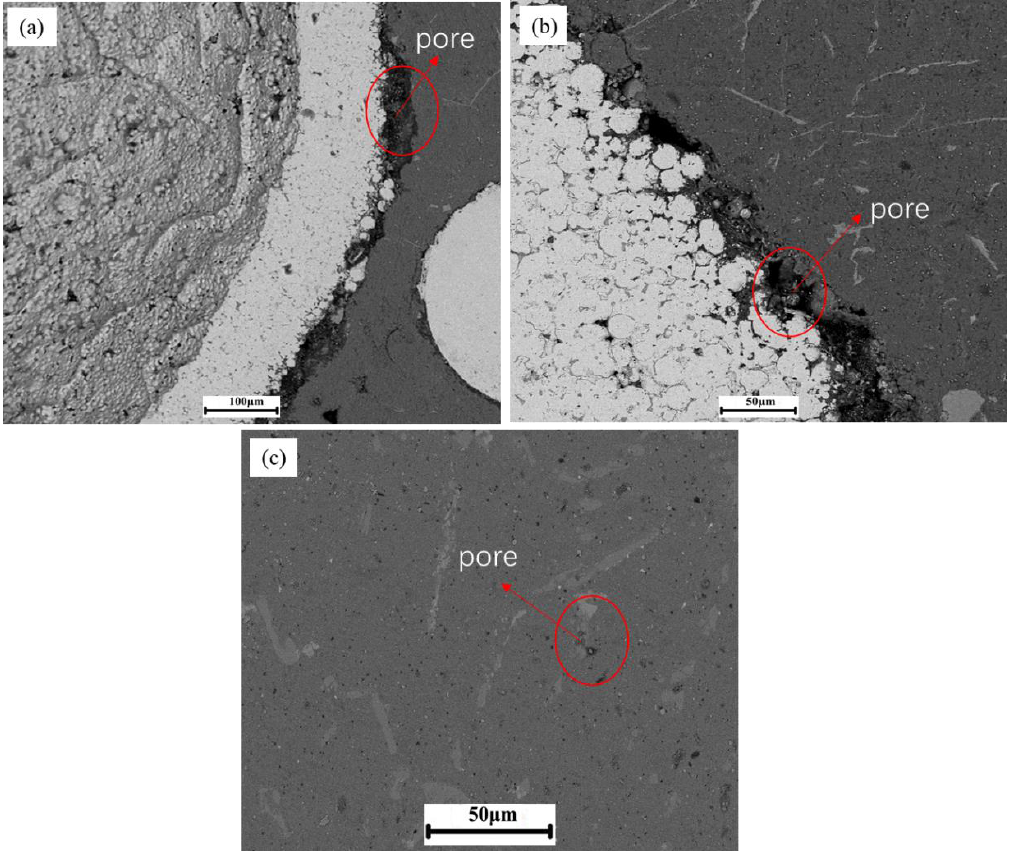
Figure 7. The interface and matrix in the MHSCs: ( a ) interface around the MHS, d = 3.28 mm; ( b ) interface around MHS, d = 5.76 mm; ( c ) matrix.